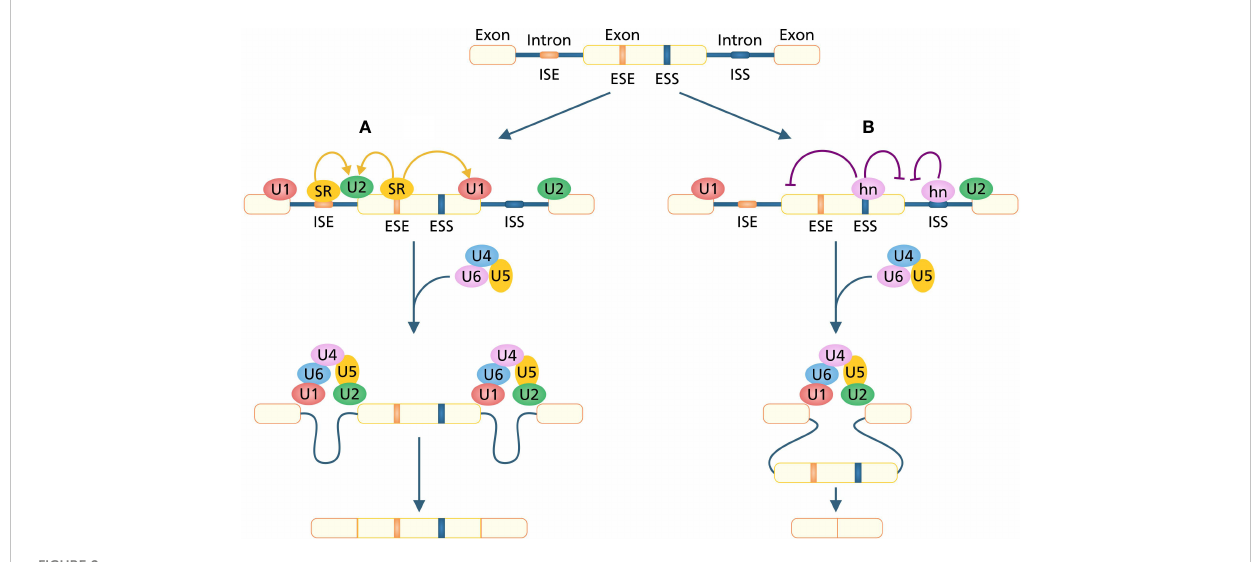
FIGURE 2 (A) The constitutive splicing in which SR proteins are attached on enhancer sites and SR proteins provide sites for the attachment of U1 and U2 on 5´ and 3´ splice sites, respectively. After complete assembly of the spliceosome, introns are excised out and exons ligated to generate mature mRNA. (B) Silencers play a role in changing the splice site selection. hnRNPs are attached to silencers, inhibiting the attachment of SR proteins which causes a shift in site selection. A shift in site selection leads to the skipping of exons and the generation of exon-missed